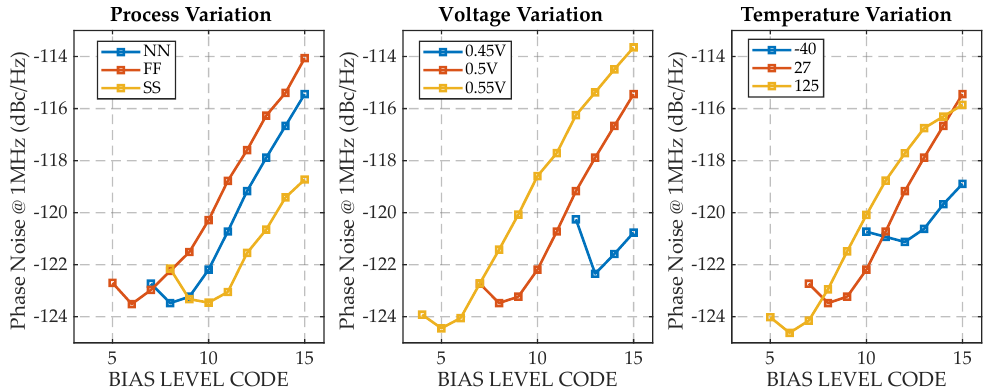
Figure 5. Tendency of phase noise according to bias voltage with process, voltage and tempera- ture variations.